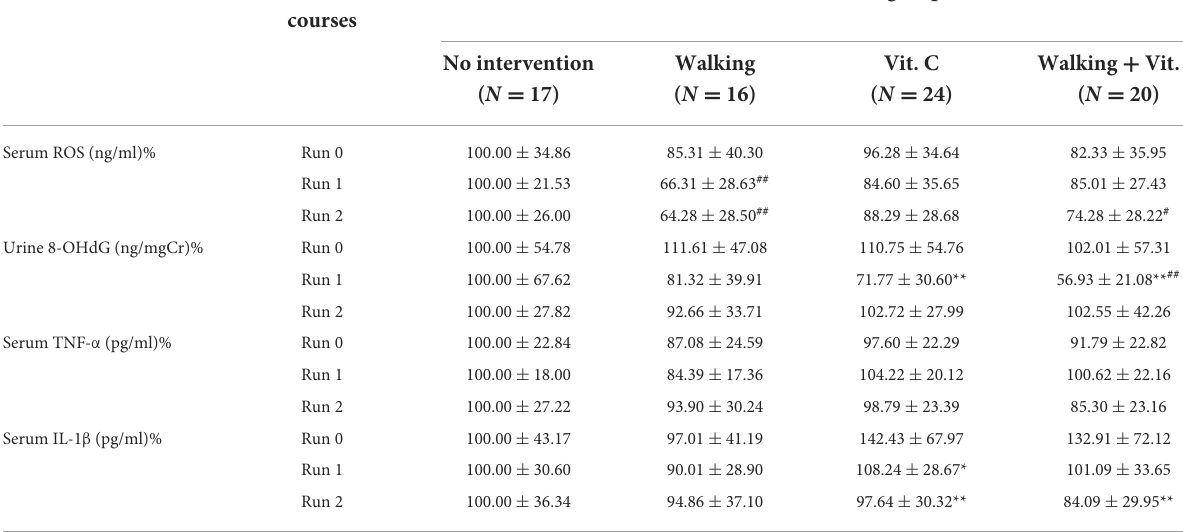
TABLE 2 Results of ANOVA-Dunnett’s test of oxidative stress and inflammatory biomarkers.